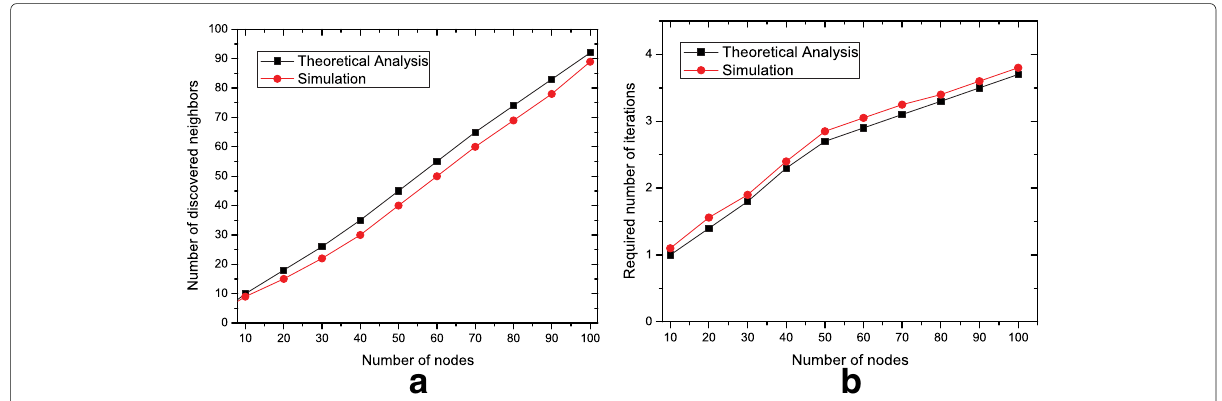
Fig. 5 Comparison of results from theoretical analysis and simulation experiments. a Neighbor discovery. b Required iterations